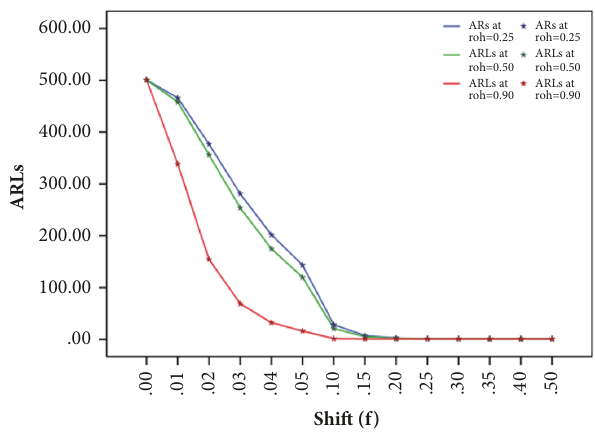
Figure 9: ARLs for proposed repetitive EWMA-RSS control chart using Khan et al. [8] ratio estimator, when 𝑟 𝑜 = 500 at 𝜆 = 0.3.